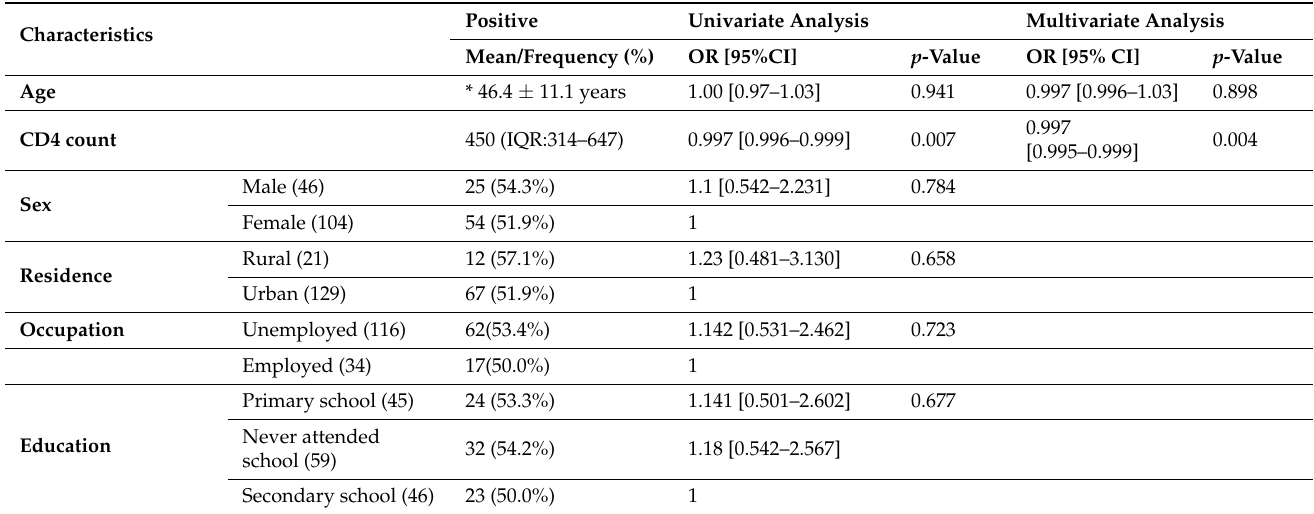
Table 3. Univariate and multivariate logistic regression analyses of the factors associated with overall SARS-CoV-2 seropositivity.